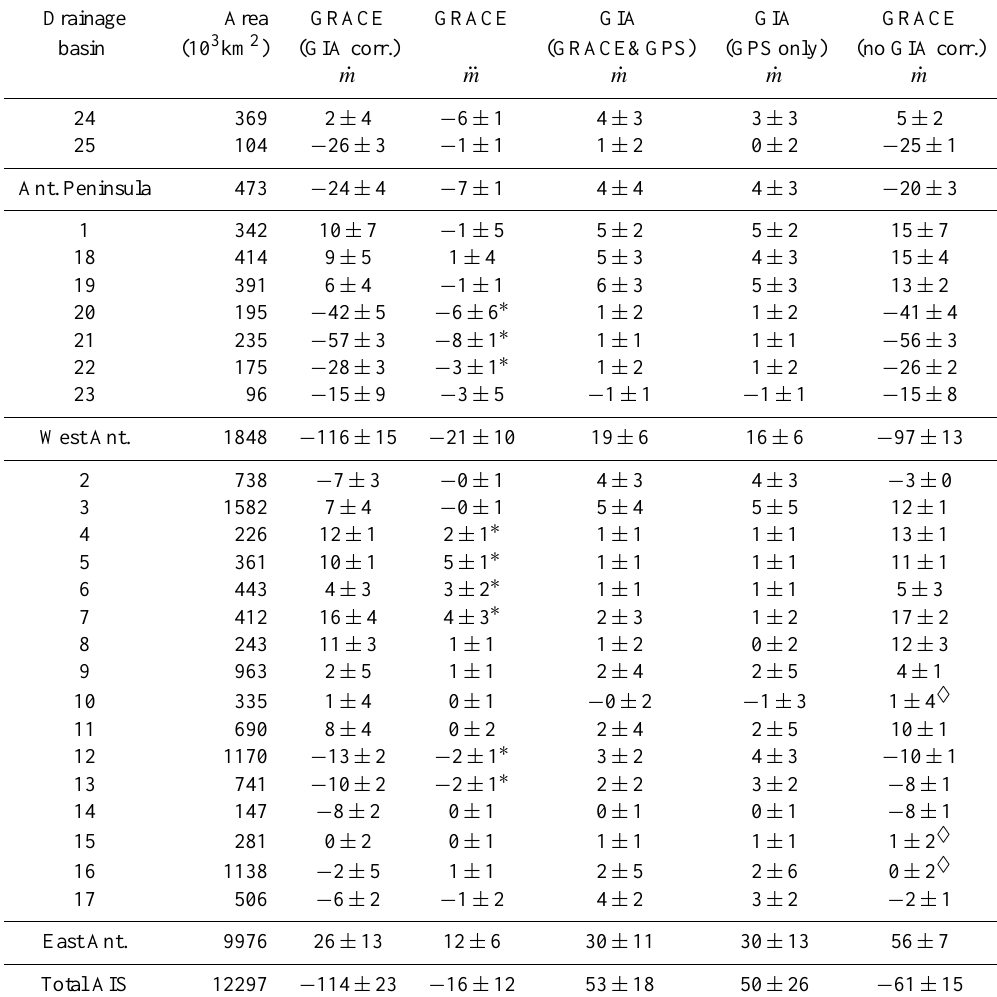
Table 2. Rate and acceleration of basins-scale ice-mass change from GRACE and revised GIA estimate AGE1b (GRACE and GPS). The GRACE estimates represent error-weighted values of GFZ RL05 and CSR RL05 estimates. ∗ denotes statistical significant acceleration terms in both GFZ RL05 and CSR RL05, while ♦ denotes linear trends that are not statistically significant in both releases (95% confidence interval: before correcting for GIA). Time period is January 2003 to September